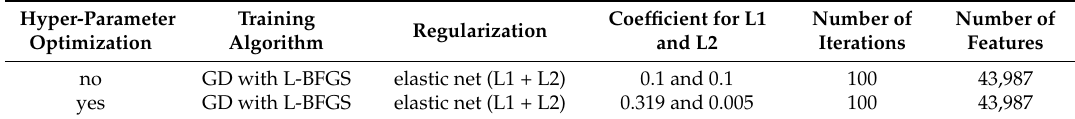
Table 3. Hyper-parameters used in the experiment.